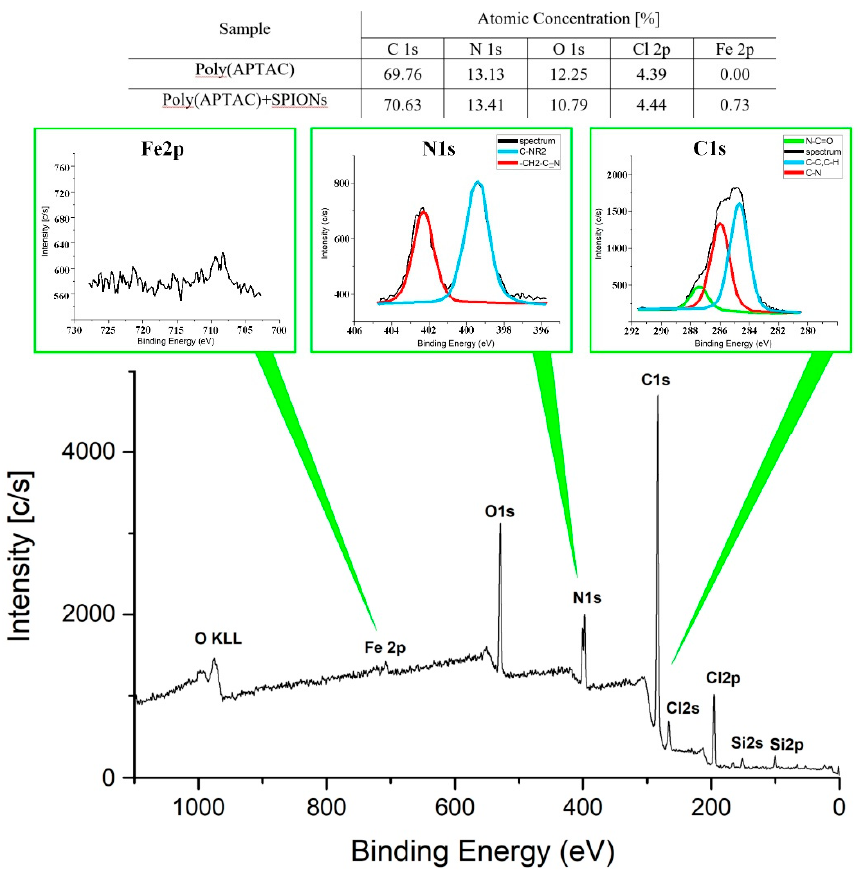
Figure 6. X-ray photoelectron spectroscopy (XPS) spectrum of poly(APTAC)+SPIONs with fragments corresponding to binding energies for Fe2p, N1s and C1s.